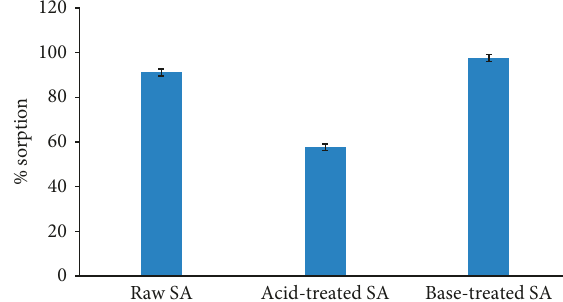
Figure 1: Effect of pretreatment on adsorption capacity of Sac- charum arundinaceum (0.1M HCl and NaOH treated sorbent, 60 minutes time, and 60ppm initial